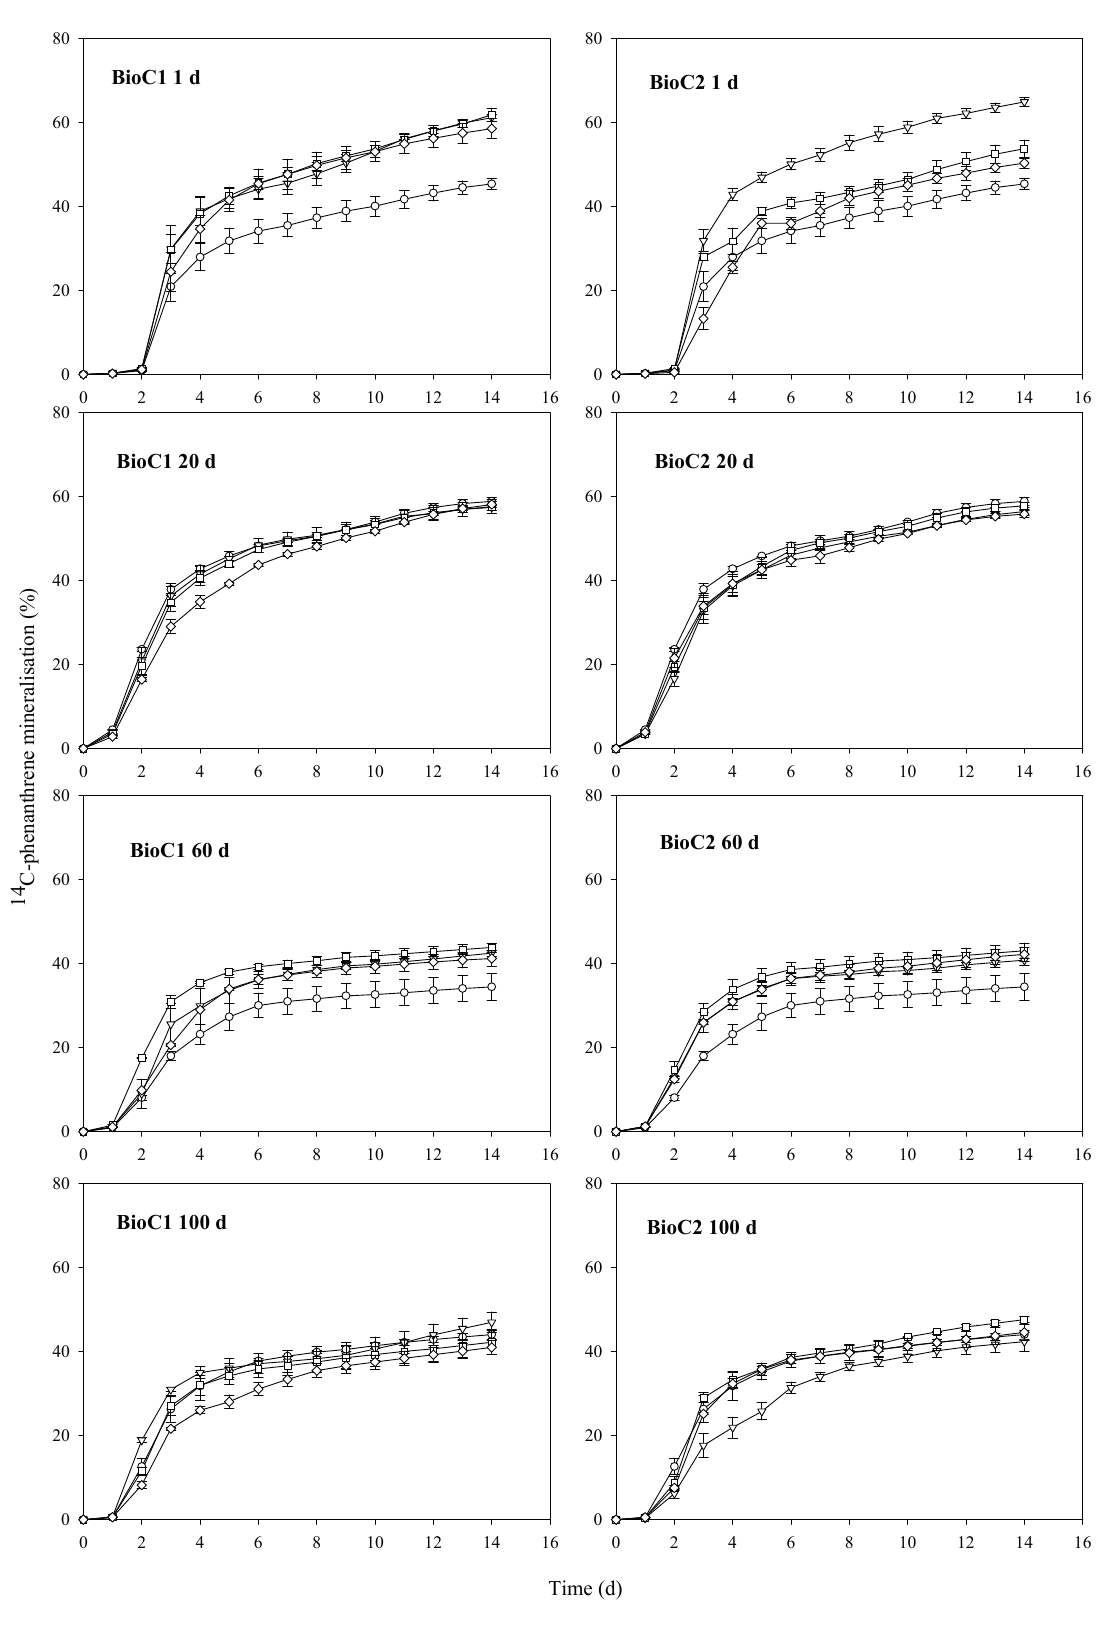
Figure 2. Mineralisation of 14 C-phenanthrene in Kettering loam soil amended with biochar at 0% ( ○ ), 0.01% ( ), 0.1% ( □ ) and 1% ( ◊ ) after 1, 20, 60 and 100 d soil-phenanthrene aging periods. Error bars represent standard error of mineralisation (SEM) ( n = 3).